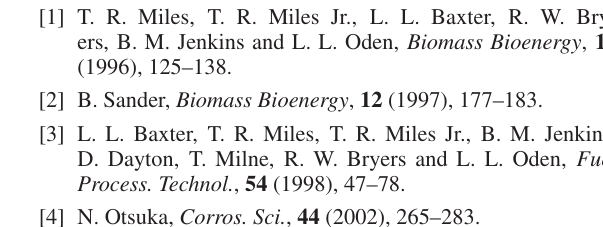
Figure 20. Secondary electron image showing the sur- face of uncoated P91 after 336 hours at 883 K in N 2 (cid:3) 20 %H 2 O (cid:3) 16:8 %O 2 . 1) Thicker